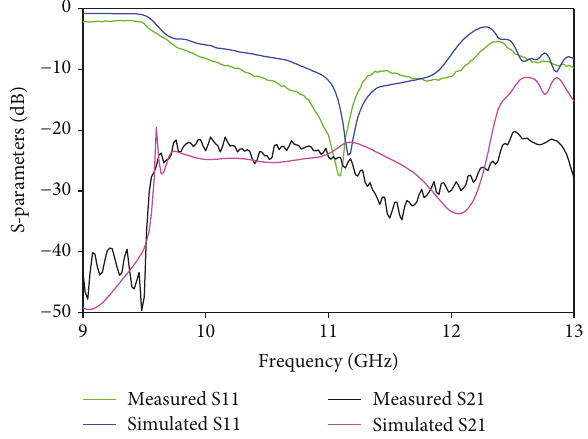
Figure 5: S-parameters of the proposed